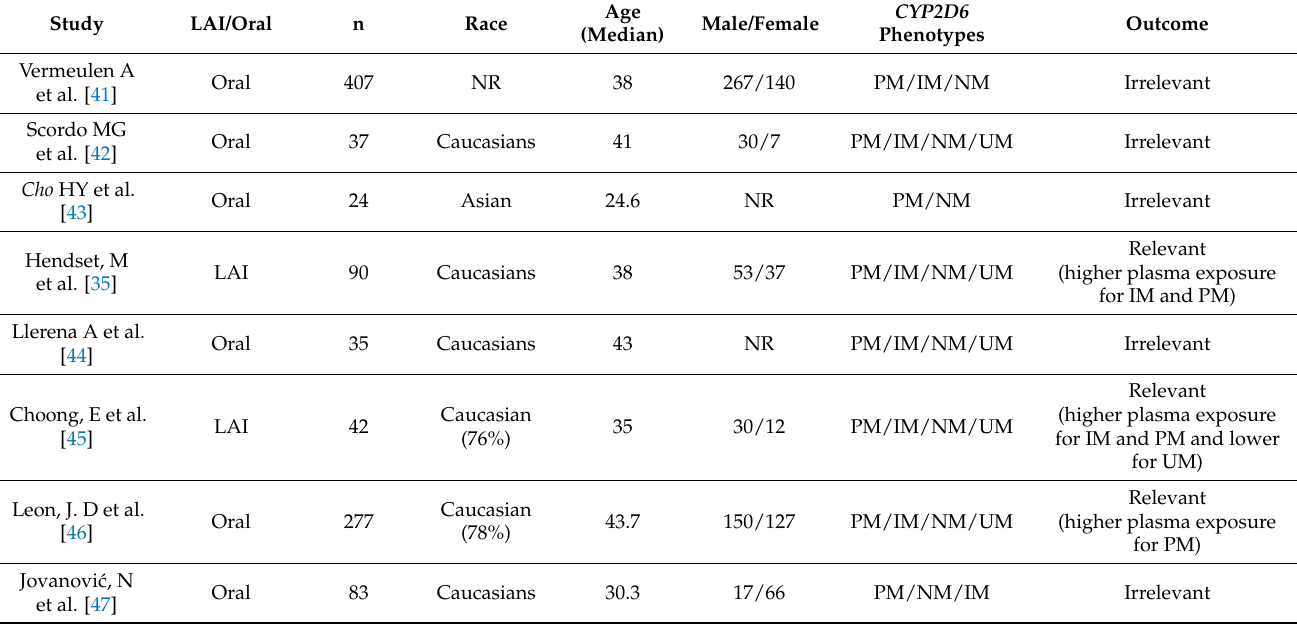
Table 1. Studies between CYP2D6 phenotype and relation with active moiety